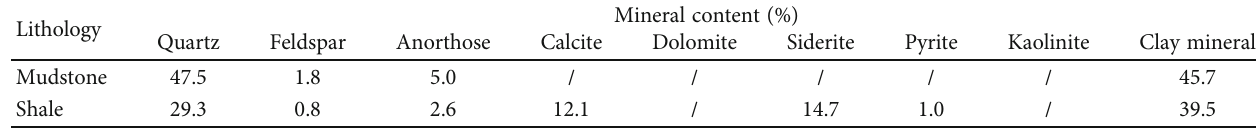
Table 3: Mineral content of the surrounding rock.